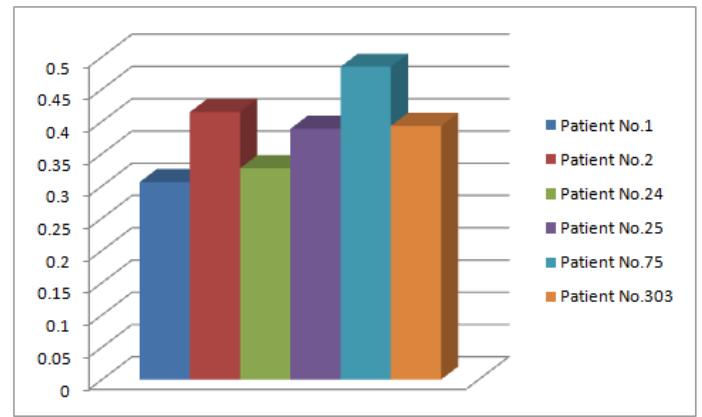
D 2 ∆ for each ˆ p i .